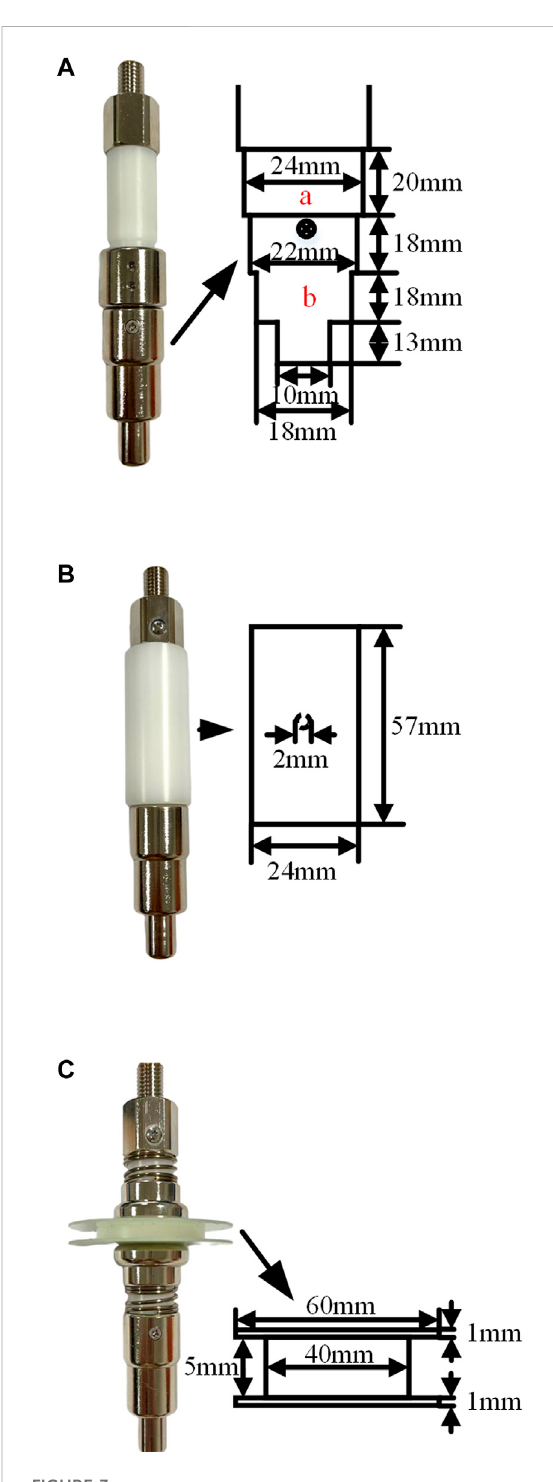
FIGURE 3 Images of insulation defect model: (A) suspension defect, (B) void defect, and (C) surface defect.